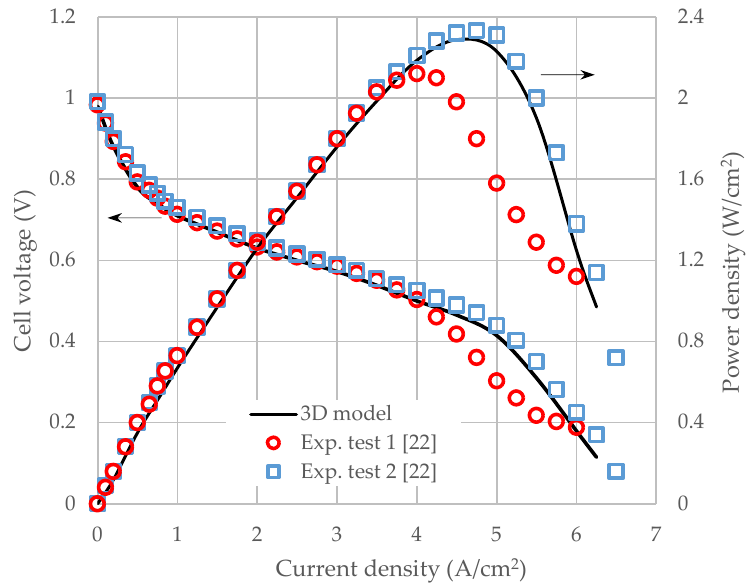
Figure 4. Comparison of the polarization and power density curves obtained from the current model and the ones reported in [22]. The black lines are the resulting curves from the numerical modeling in the present study, while the red circles and blue squares are the results of the experimental tests in the reference study.